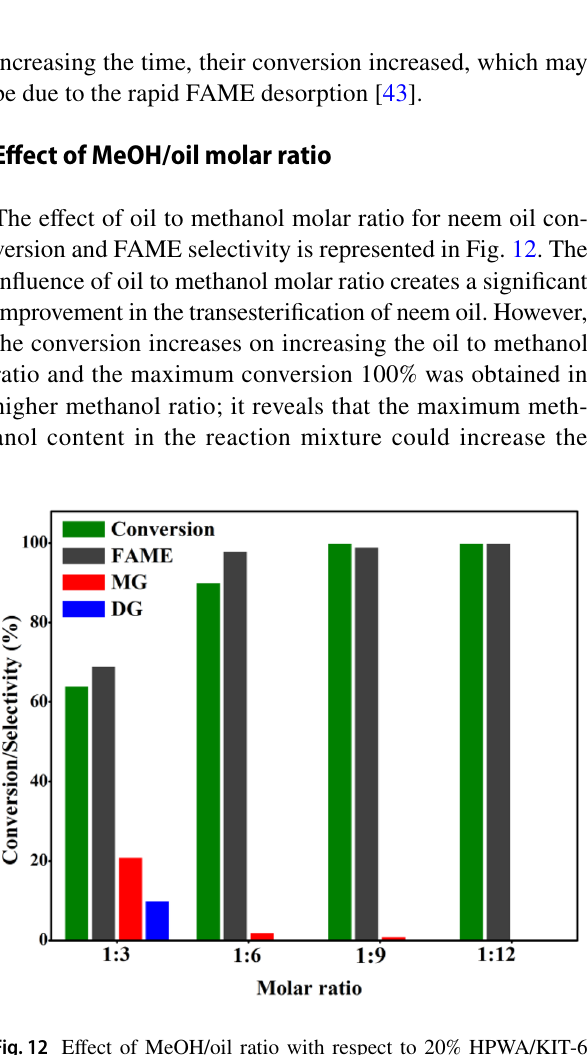
Fig. 11 Effect of reaction time with respect to 20% HPWA/KIT-6 in transesterification of neem oil [Reaction conditions: catalyst, 0.35 g; oil, 10 g; 60 °C; run time, 1–5 h; MeOH/oil (mole), 10]